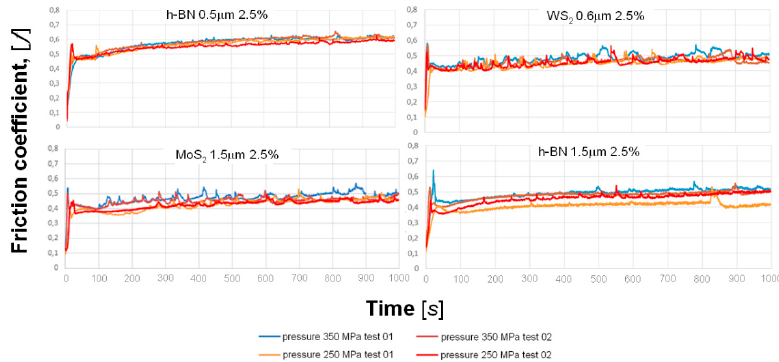
Figure 19. Function sequence in the friction coefficient during the test.